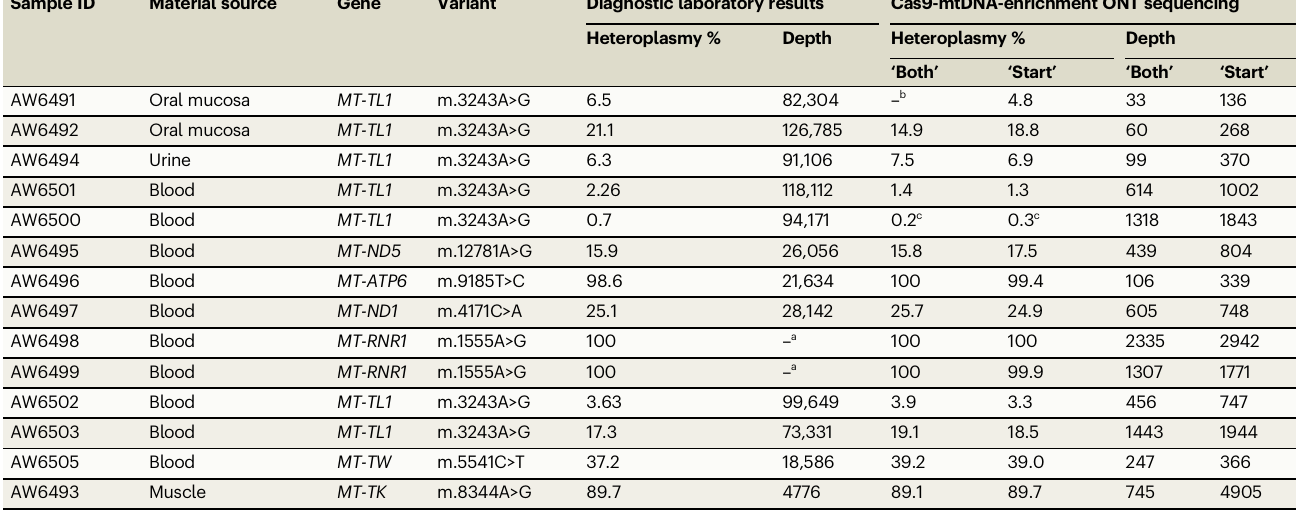
Table 1 | Pathogenic SNV identi fi cation and heteroplasmy determination in the con fi rmed clinical samples with mtDNA